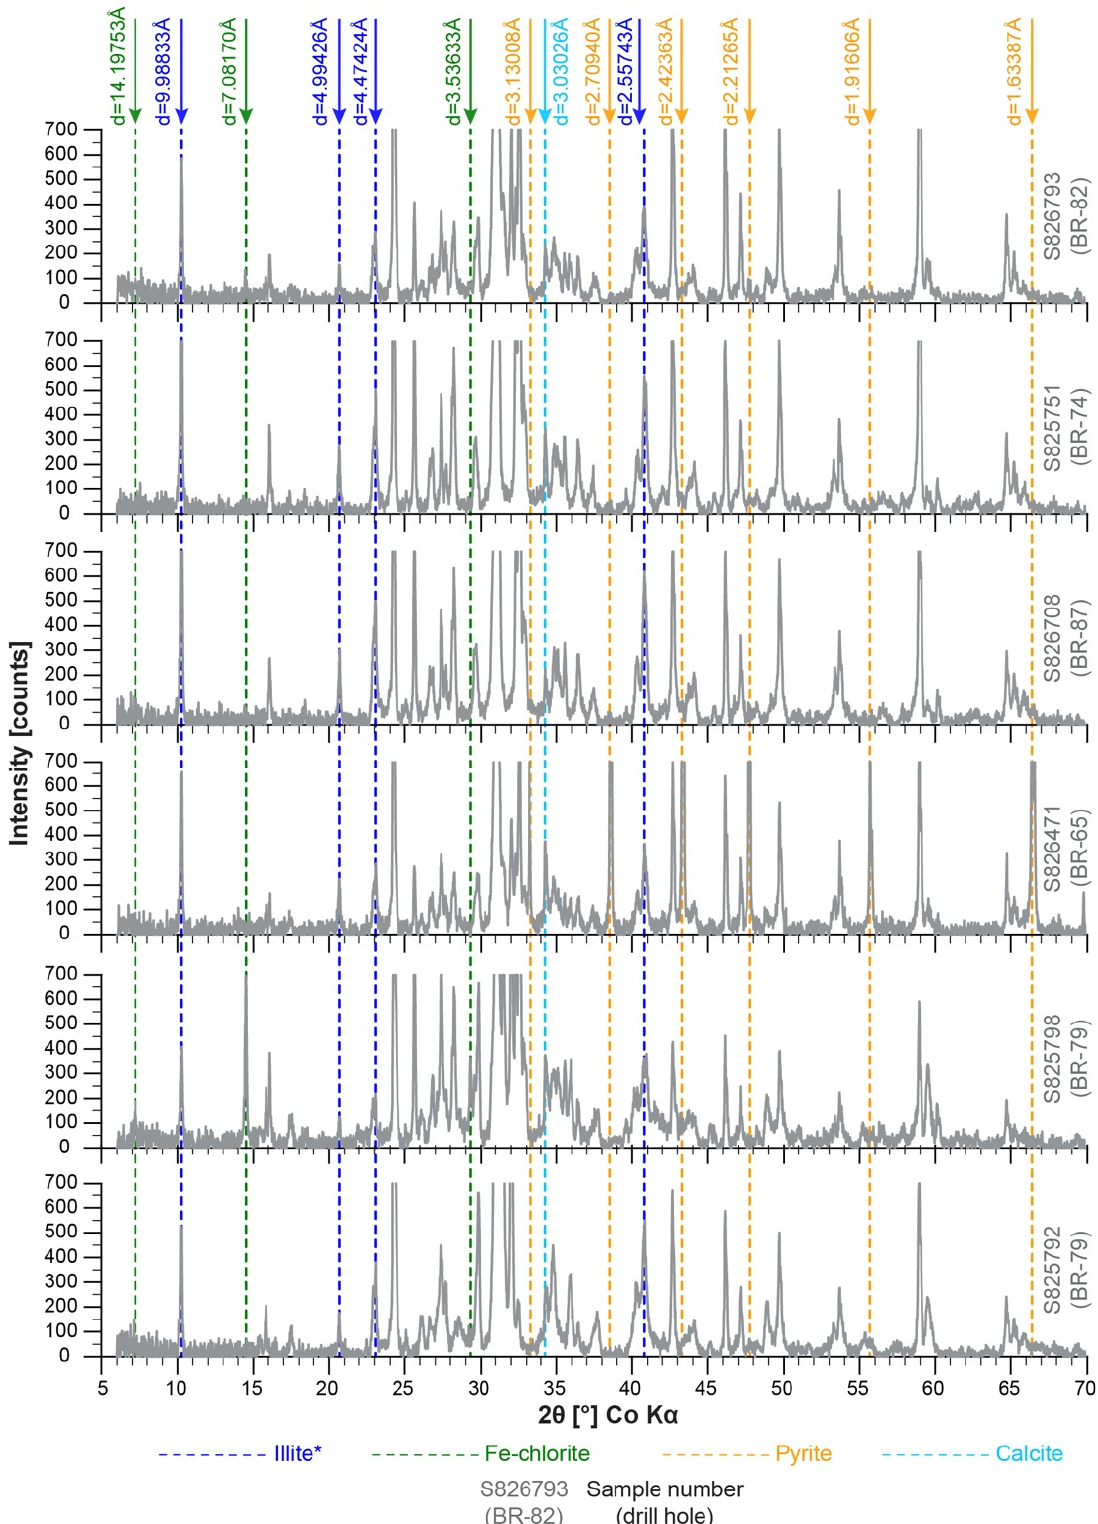
Figure 16. XRD spectra for random oriented samples of <2 μ m fraction (untreated, air dried) of felsic volcanic rocks. Peaks and d spacings for selected phases are highlighted in dashed lines and arrows, respectively. Note: * XRD identified muscovite; however, EMPA shows illite composition, and both spectra are very similar and cannot be distinguished by powder XRD based on the applied method.